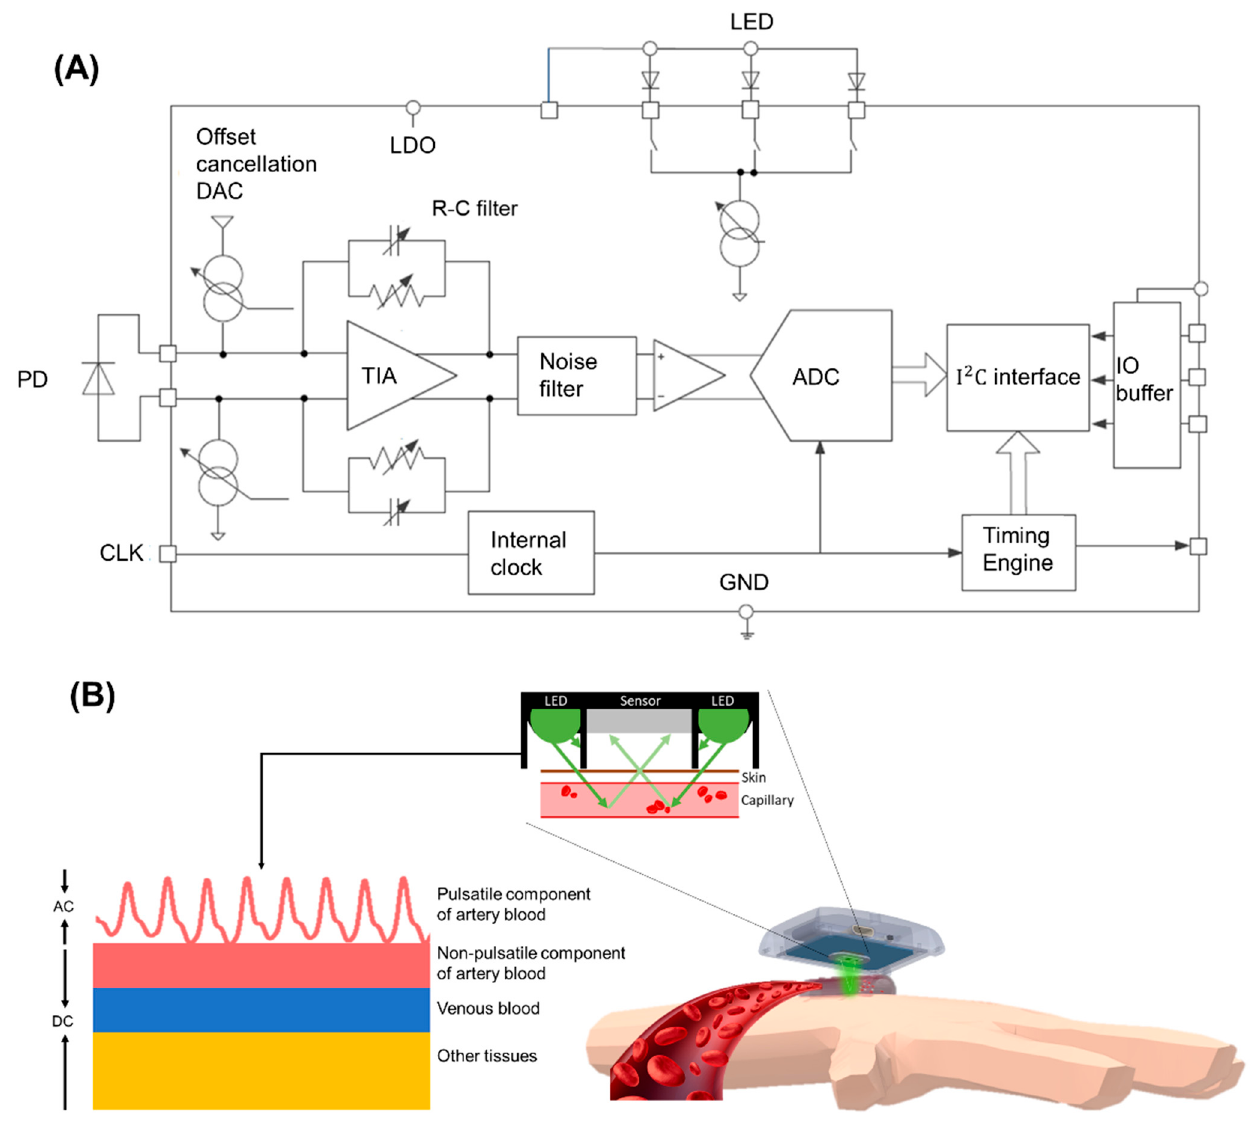
Figure 2. ( A ) Shows the circuit of the PPG analog front end. It contained an LED, adjustable R-C filter, TIA to enhance the signal from the PD and convert the signal to digital data by ADC. ( B ) The optical principle of the PPG sensor that reflecting the blood volume variation from PPG signal. The PPG sensor with the optical shielding design for decreasing noise and disturbance acquired reflective PPG signal including AC and DC components. AC was defined as the pulsatile component of the artery and DC was consisted of non-pulsatile components of artery blood, venous blood, and other tissues. As shown in Figure 2B, the PPG signals acquired from the PPG sensing module could be individually divided into the DC and alternating current (AC) components. The DC component was attributed to the bulk absorption of the skin, muscle, venous blood, non- pulsatile components of artery blood, and unfluctuating tissue. The AC component was directly attributable to a pulsatile component of arterial blood and showed the changes in the blood volume that occurred between the systolic and diastolic phases of the cardiac cycle. The green light was used to observe the PPG waveform because of the large AC component and good signal-to-noise ratio. Each cardiac cycle was determined as a pressure pulse wave when the blood was perfused to the dermis and subcutaneous tissue of the skin in each ventricular